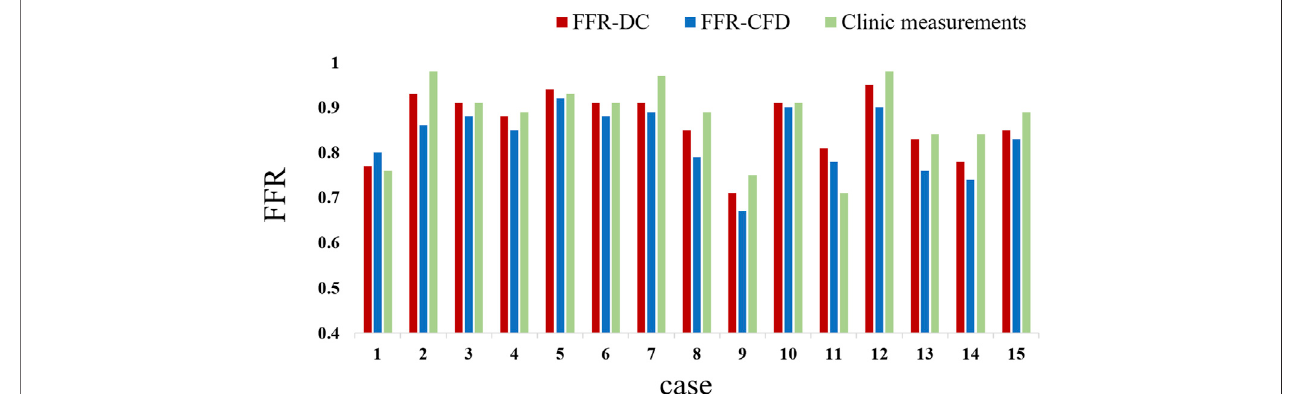
FIGURE 6 | Comparison between clinically measured FFR and FFRct calculated with different models.